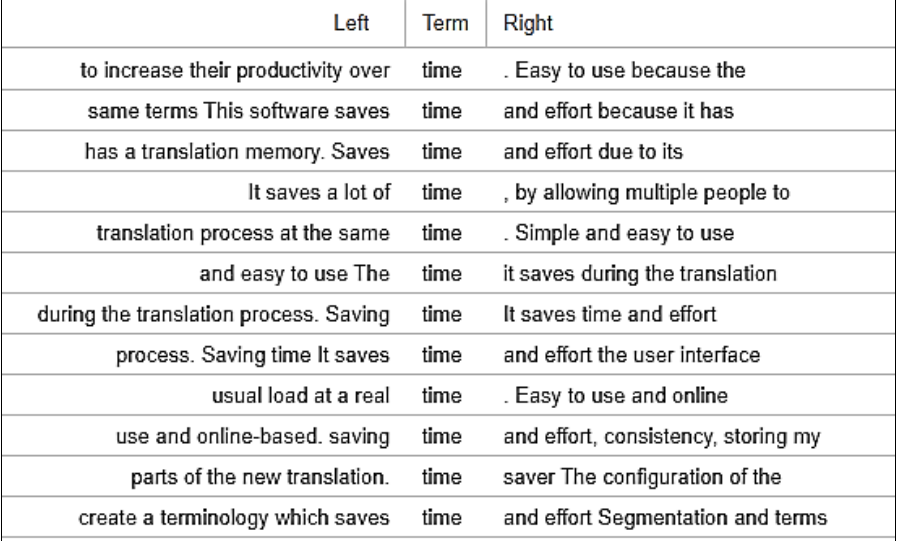
Figure 4. Concordance results for the most frequent word in participants’ responses on the best feature of CAT. Appl. Sci. 2020 , 10 , x FOR PEER REVIEW